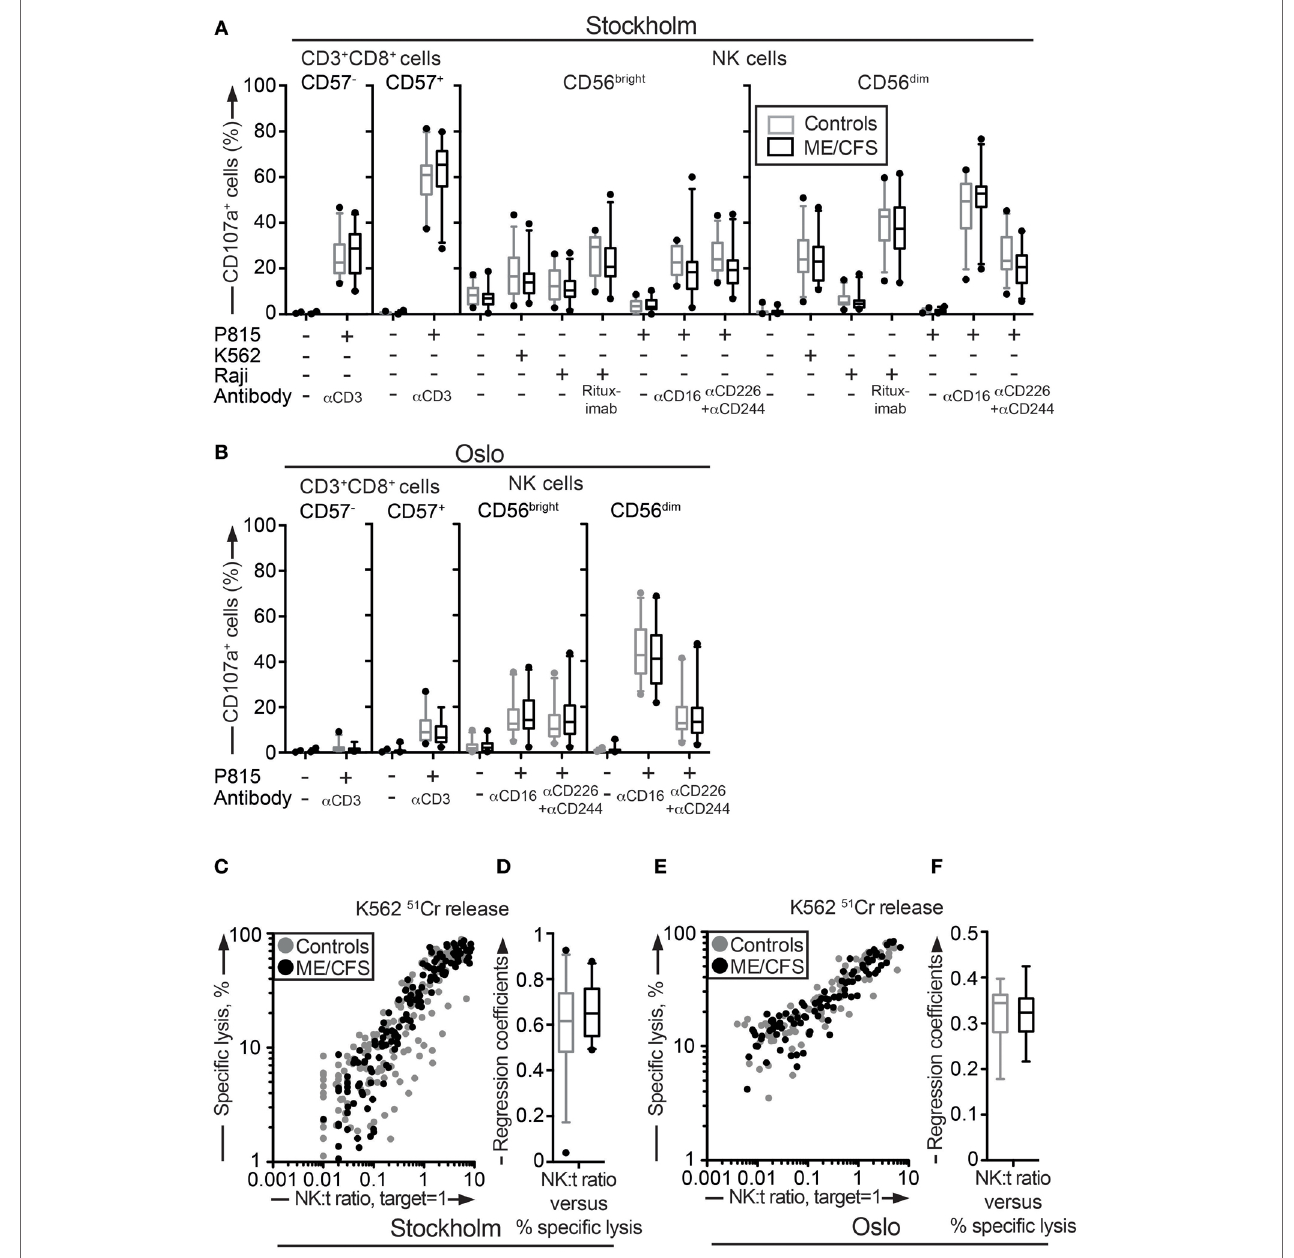
FIGURE 2 | Assessment of exocytosis as well as K562 killing are not different between ME/CFS patients and controls. (A,B) Analysis of exocytosis. PBMC were thawed, rested overnight and then stimulated for 4h with no target, P815 + anti-CD3, K562, Raji, Raji + Rituximab, P815, P815 + anti-CD16, P815 + anti-CD244 (2B4) + antiCD226 (DNAM-1), and subsequently stained with antibodies to CD107a in combination with lineage markers. Percentage of four CD8 + T cell and NK cell subsets positive for CD107a in the Stockholm and Oslo substudy respectively is shown. Gray boxes depict control values, whereas black boxes depict patient values. Lines through boxes show the median. Error bars extend to 5th and 95th percentile. Dots show outliers. (C,E) K562 lysis of NK cells from the Stockholm and Oslo substudies. NK cell activity measured with K562 lysis. K562 cells were labeled with 51 Cr, and subsequently co-cultured with PBMC for 4h at six standardized PBMC concentrations. Subsequently, gamma-emissions from the supernatants were registered. X -axis shows the NK:target ratio, with the target set to 1. The NK cell values are estimated from average percentage of NK cells in simultaneously performed flow cytometric assay. Y -axis shows specific lysis in percent, calculated with the formula (100 × ( x − min)/(max − min)), where x = average value from duplicates or triplicates (Stockholm and Oslo analysis, respectively), min = average value from negative control triplets, max = average value from positive control triplets. Gray dots depict control values; black dots depict patient values. (D,F) Regression coefficients for the specific lysis in percent as a function of the NK:target ratio calculated for every individual for the Stockholm and Oslo analysis, respectively. Gray boxes depict control values, whereas black boxes depict patient values. Lines through boxes show the median. Error bars extend to 5th and 95th percentile. Dots show outliers. 24 patients and 28 controls for the Stockholm substudy and, 22 patients and 24 controls [15 patients and 16 controls for (E,F) ] for the Oslo substudy, are included in the